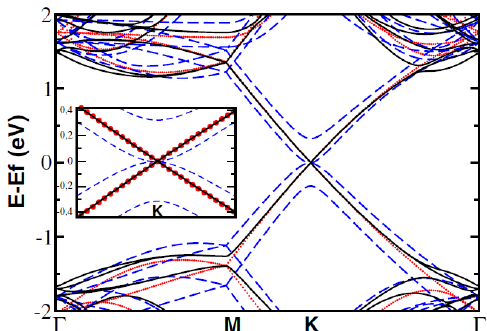
Figure 1. Band structure for a monolayer graphene (dotted line), a bilayer graphene with AB stacking (dashed line), and R30/R2 + rotational fault pair (single line). Band structure at the K -point is given in the inset. Reprinted with permission from Reference [22]. Copyright (2008) by American Physical Society.